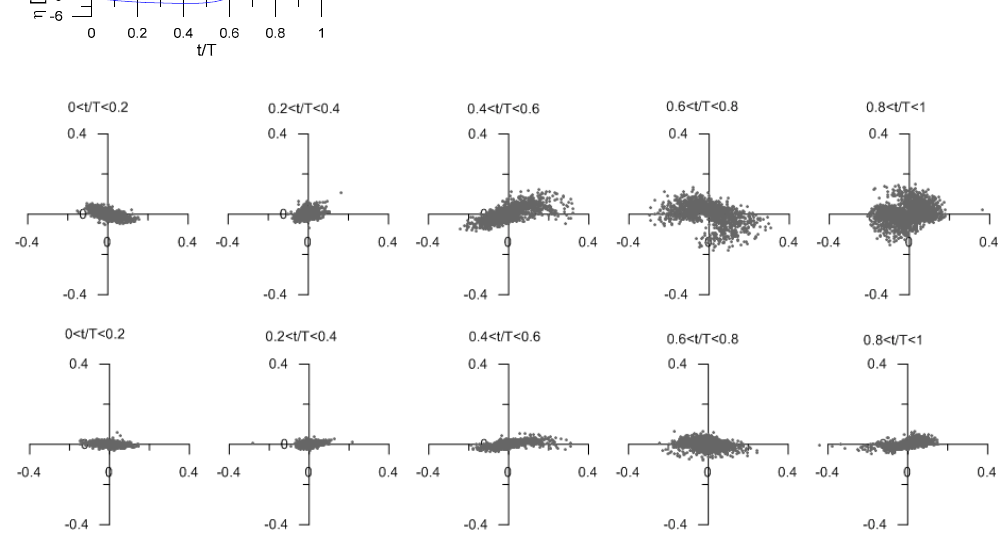
Figure 9. Test_S, section 47: quadrant plots in five phase intervals, at z/h =0.7 (top row) and z/h =0.3 (bottom row).